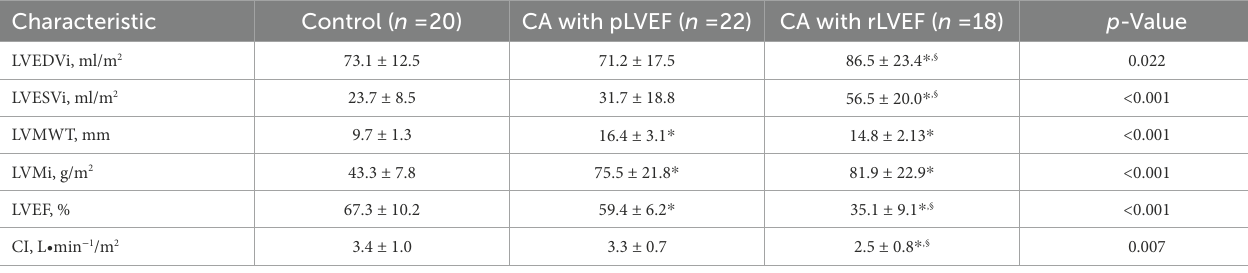
CA, cardiac amyloidosis; rLVEF, reduced left ventricular ejection fraction; pLVEF, preserved left ventricular ejection fraction; CMR, cardiac magnetic resonance; LVEDVi, left ventricular end- diastolic volume index; LVESVi, left ventricular end-systolic volume index; LVMWT, left ventricular maximal wall thickness; LVMi, left ventricular mass index; CI, cardiac index.